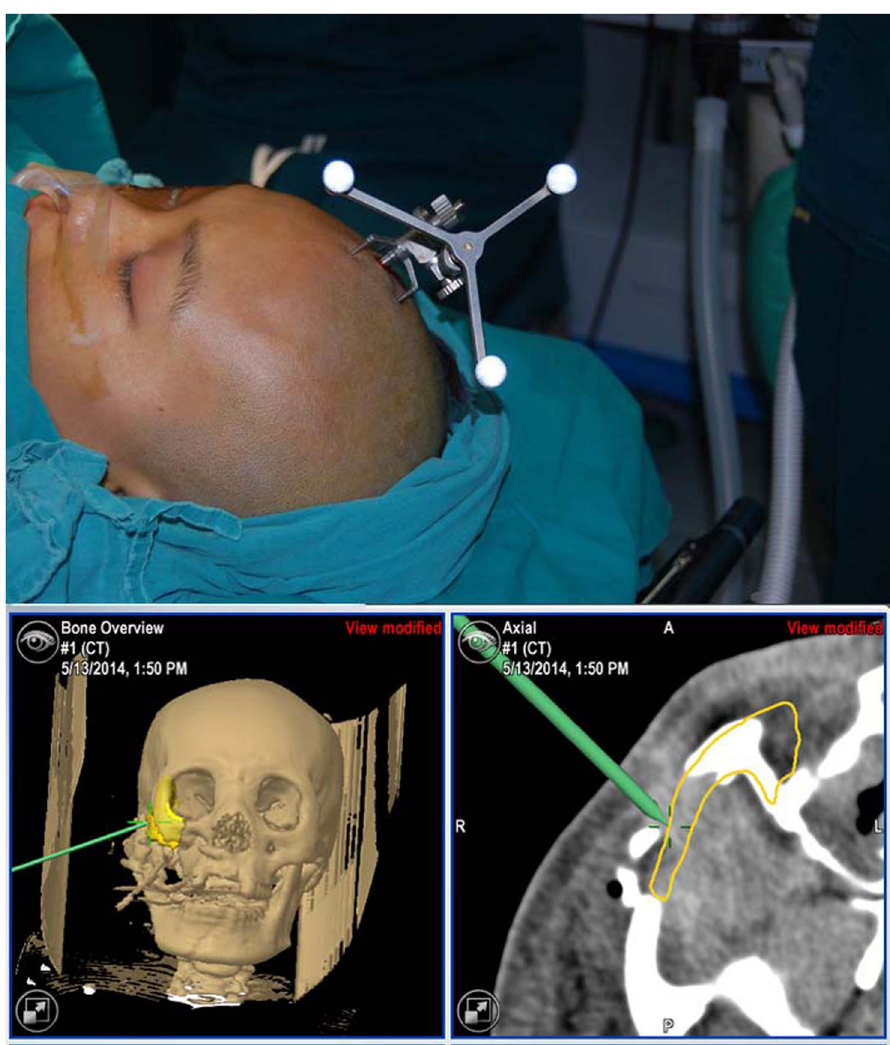
Figure 1. Intraoperative navigation. ( A ) Digital reference frame was fixed; ( B ) Fracture reduction with guidance of surgical